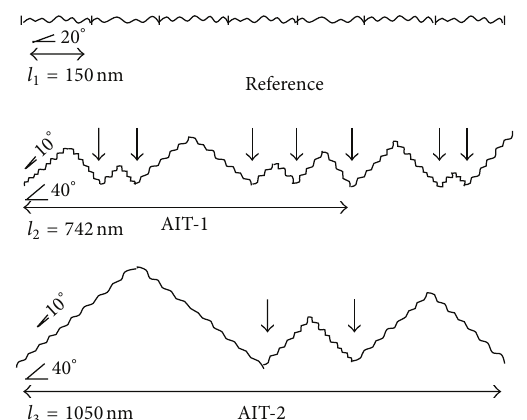
Figure 4: Schematic of the “simplified surface model” for the three different superstrates